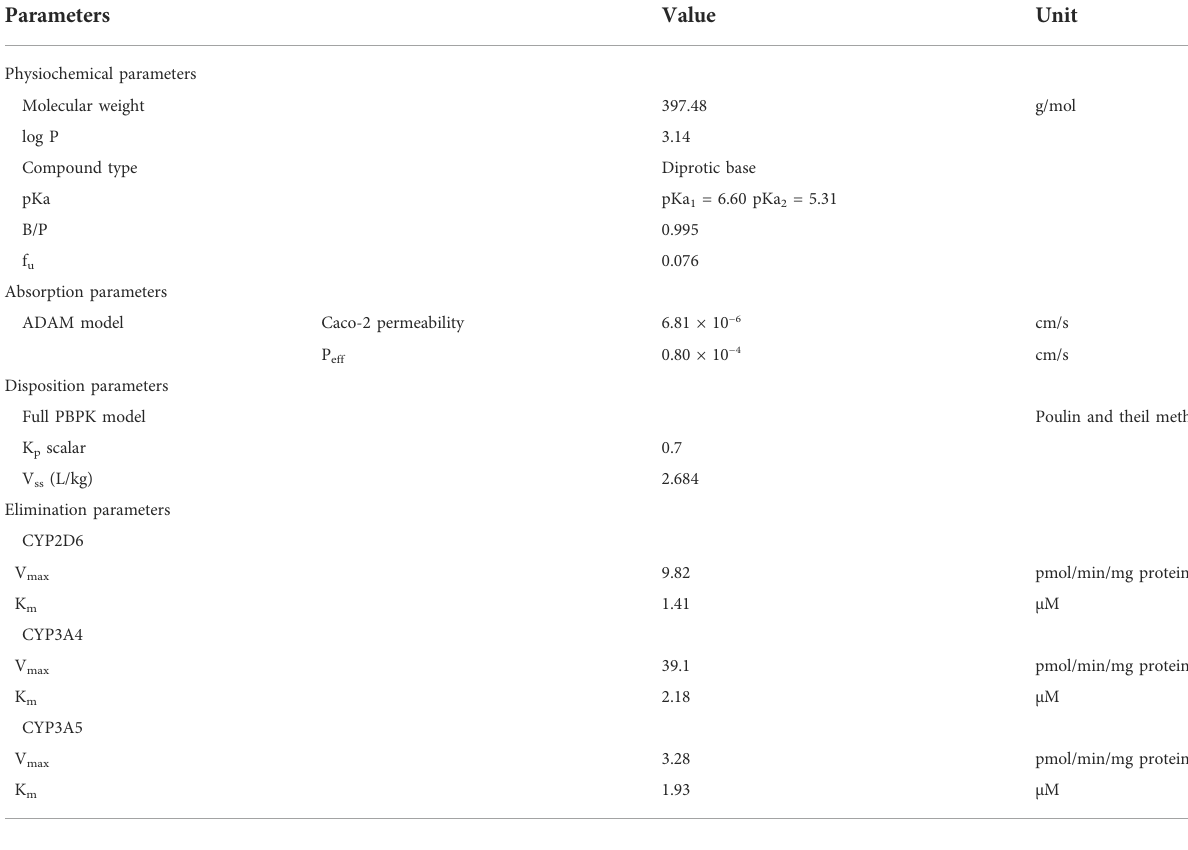
TABLE 2 PBPK model parameters for apatinib (Liu et al.,